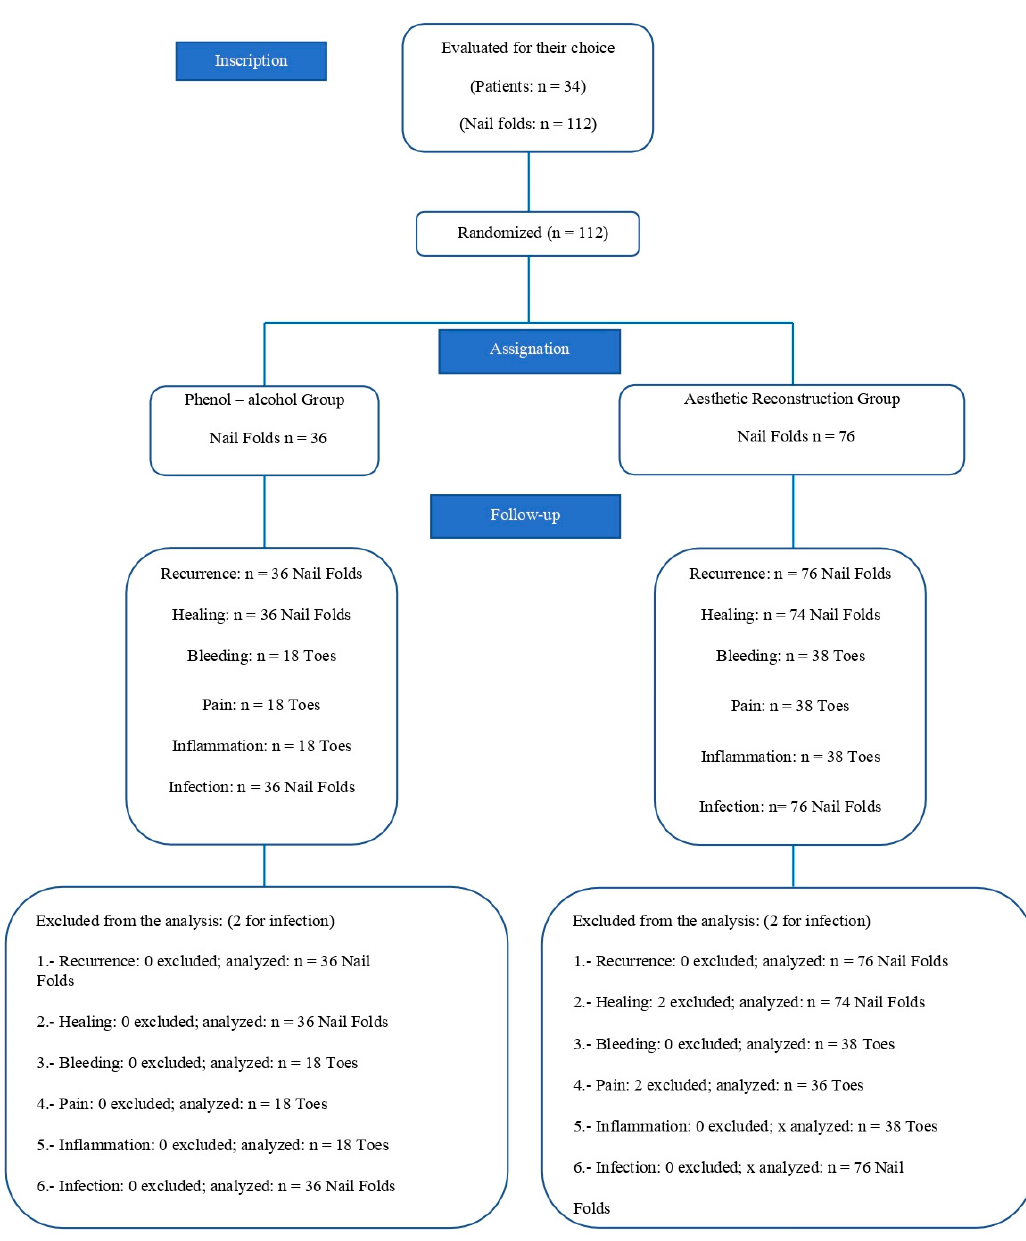
Figure 2. Flow diagram of patients throughout the course of the study.